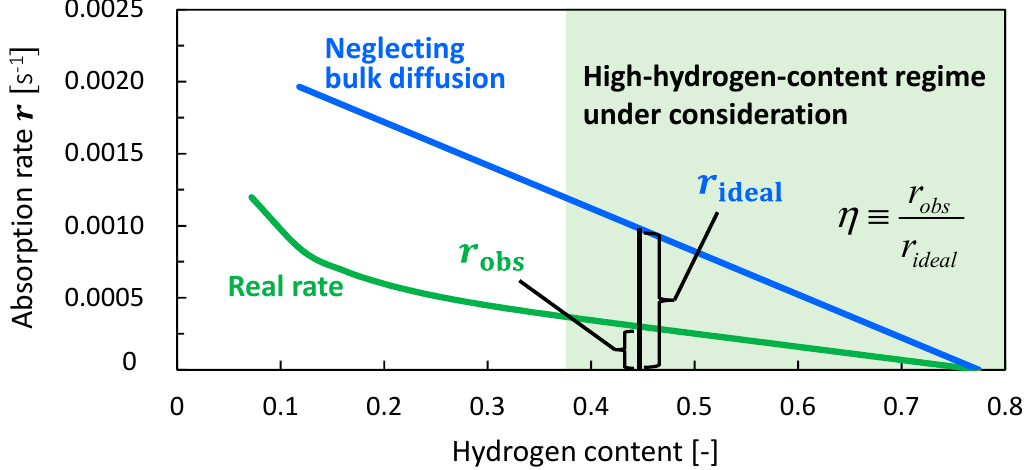
Figure 14. Conceptual schematic for definition of effectiveness factor η ; η = r obs / r ideal , where r obs and r ideal are the actually observed hydrogen absorption rate that accounts for bulk diffusion and the virtual absorption rate that was calculated neglecting the bulk diffusion process. r obs and r ideal were plotted against the hydrogen content.